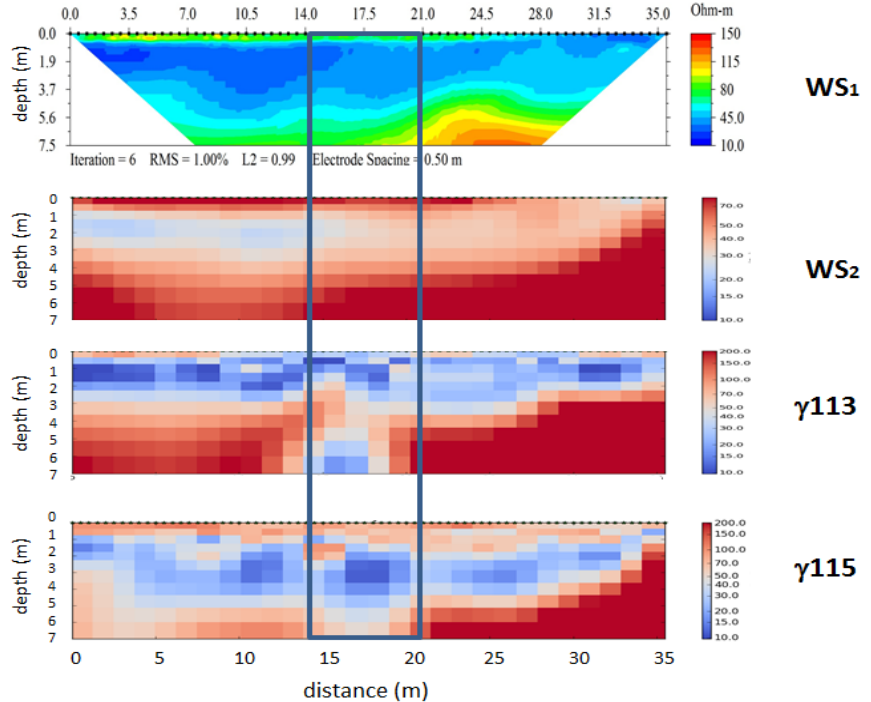
Figure 6. Characterization of a fault and a water-bearing fracture zone by the traditional WS array (inverted by EarthImager code: WS 1 , by Res2D-Hu code: WS 2 ) and two quasi null arrays (Section 3.1.2).